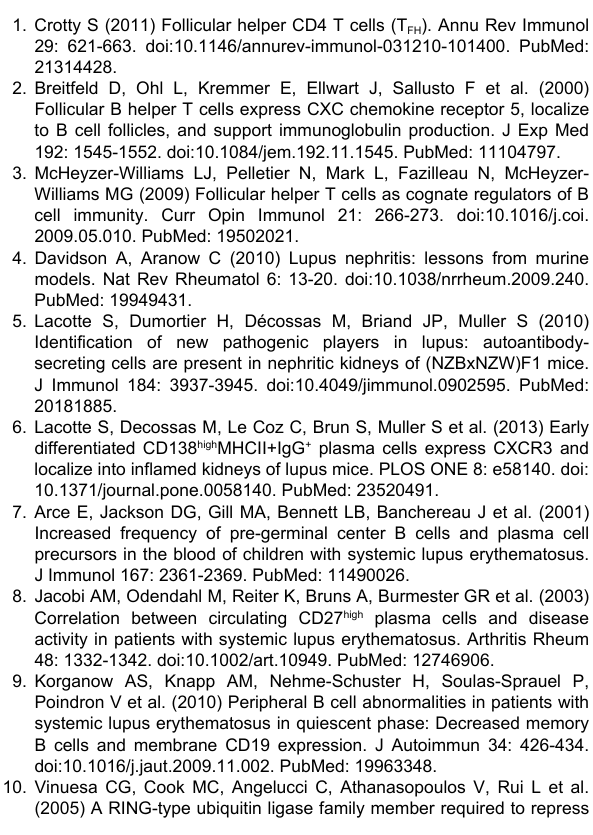
Figure S2. T cell subset distribution in active SLE patients. FH T cell subset distribution in active SLE patients (n = 6), FH inactive SLE patients (n = 13), and sex and age-matched healthy controls (n = 19) is represented. Each data point represents an individual subject; horizontal lines show the mean ± sem. * p < 0.05, ** p < 0.01, *** p < 0.001, **** p < 0.0001 (one-way ANOVA test). ns: not